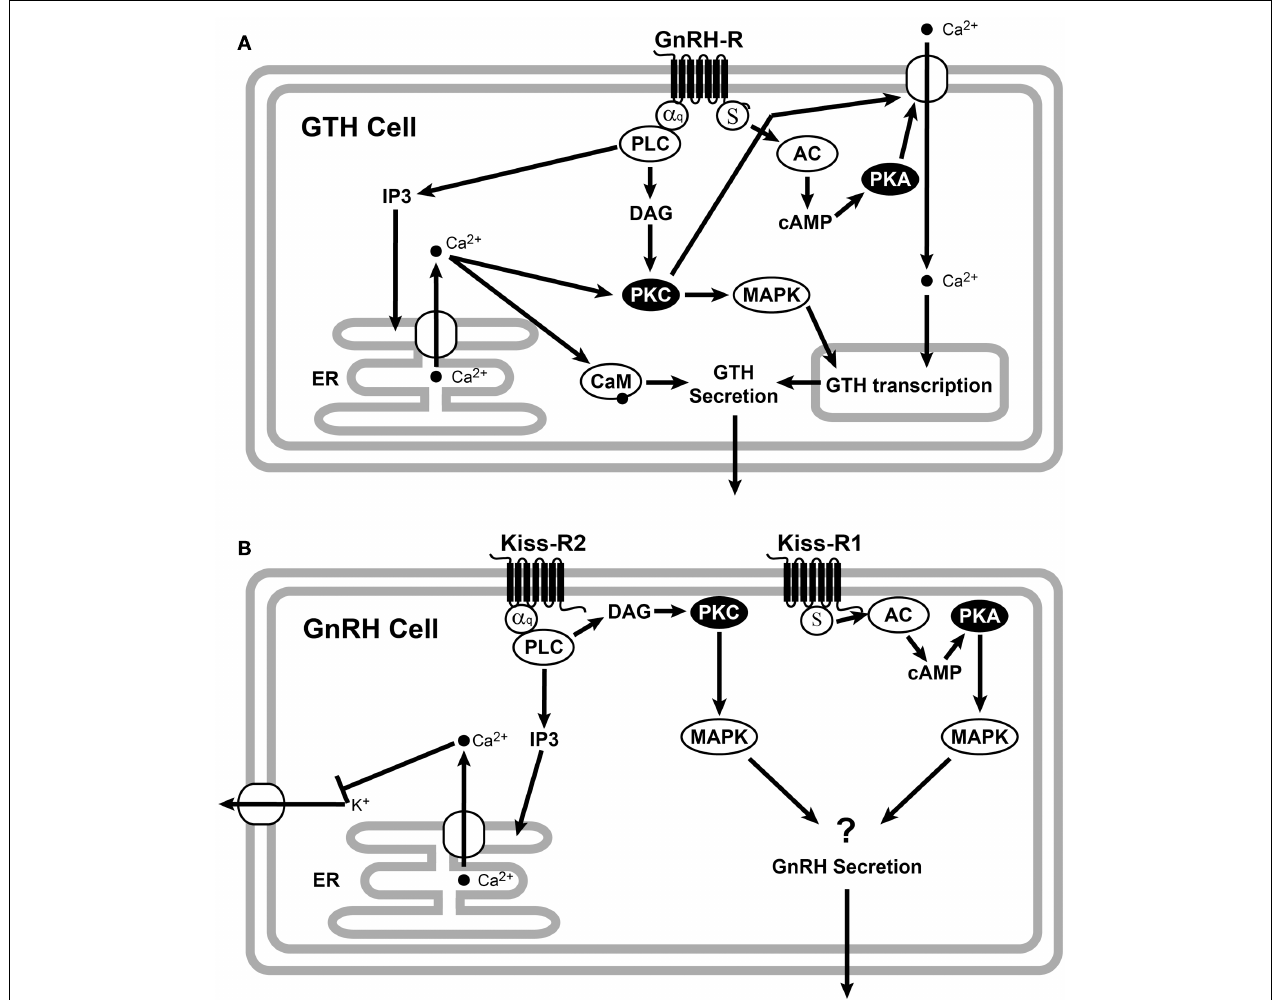
loading on Gs and increased intracellular cAMP via activation of adenylyl cyclase (AC), which elevates GnRH release via the cAMP-dependent protein kinase (PKA) (Liu et al., 2002). (B) Binding of kisspeptin to teleosts Kiss-R2 activates the Gq/11 and PLC to generate IP3 and DAG. IP3 causes intracellular Ca 2 + release from the ER, which activates PKC and mitogen-activated protein kinase (MAPK) cascade. However,